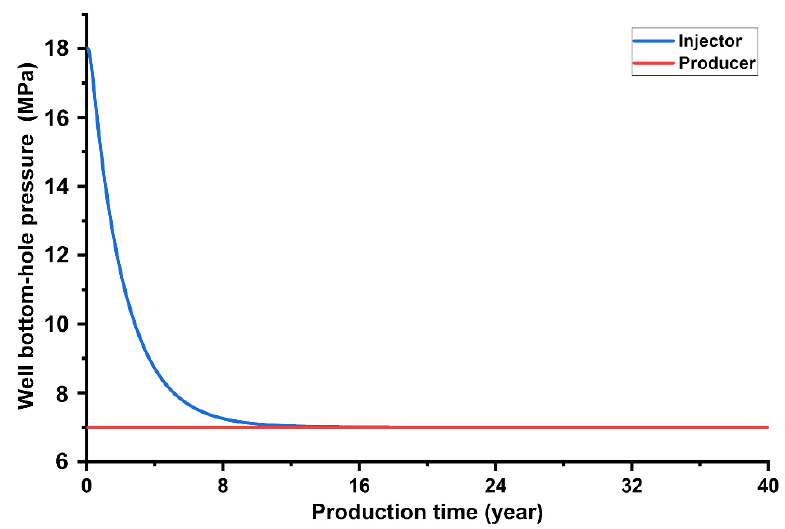
Figure 2. Bottom-hole pressure in injection and production wells.